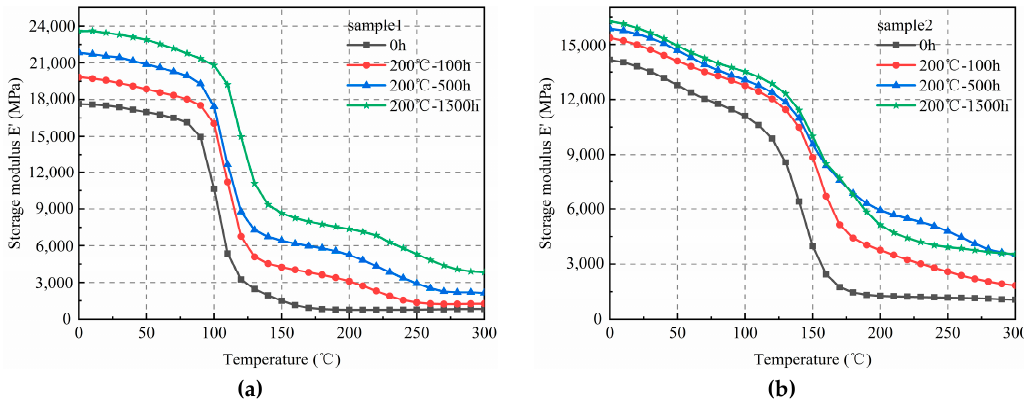
Figure 5. Elasticity modulus of the EMC at different aging times (temperature = 200 ◦ C). ( a ) Sample 1; ( b ) Sample 2.